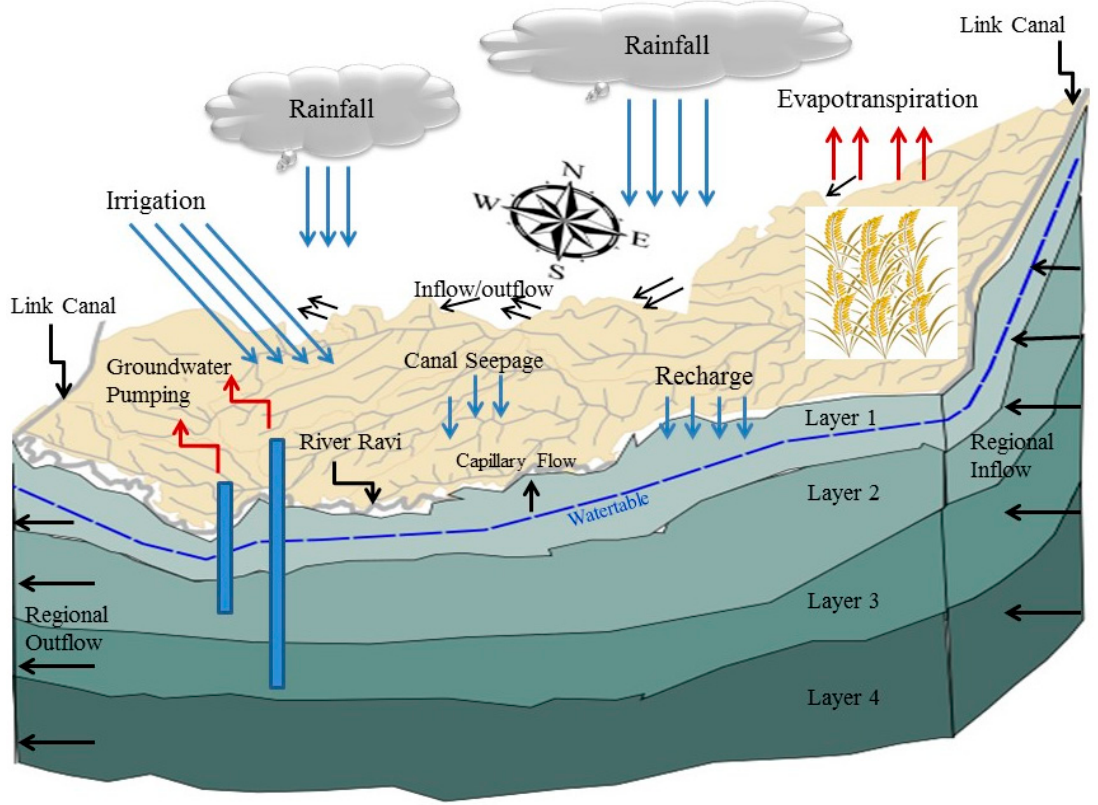
Figure 2. Schematic diagram of the conceptual model.